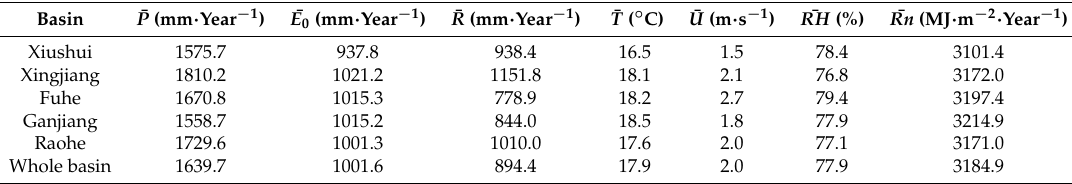
Table 3. Basic characteristics of the PYLB. ¯ P , ¯ E 0 , ¯ R , ¯ T , ¯ U , ¯ RH and ¯ Rn represent the mean annual values of precipitation, evaporation, runoff depth, temperature, wind speed, relative humidity and net radiation.